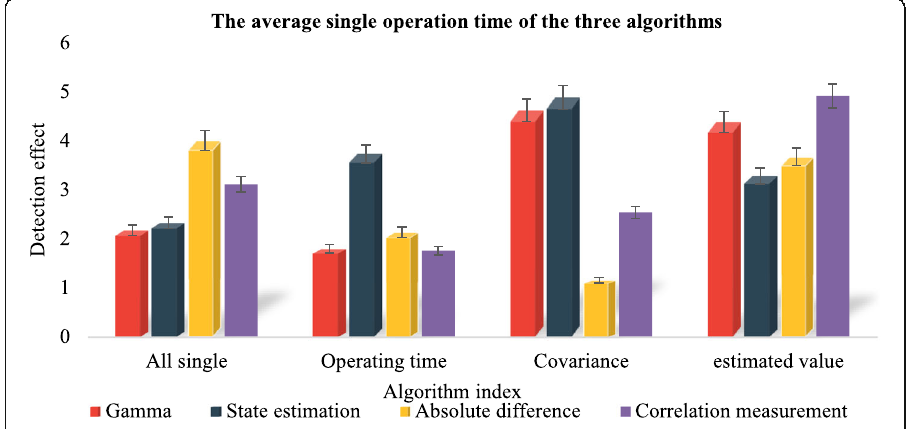
Fig. 4 The average single operation time of the three algorithms